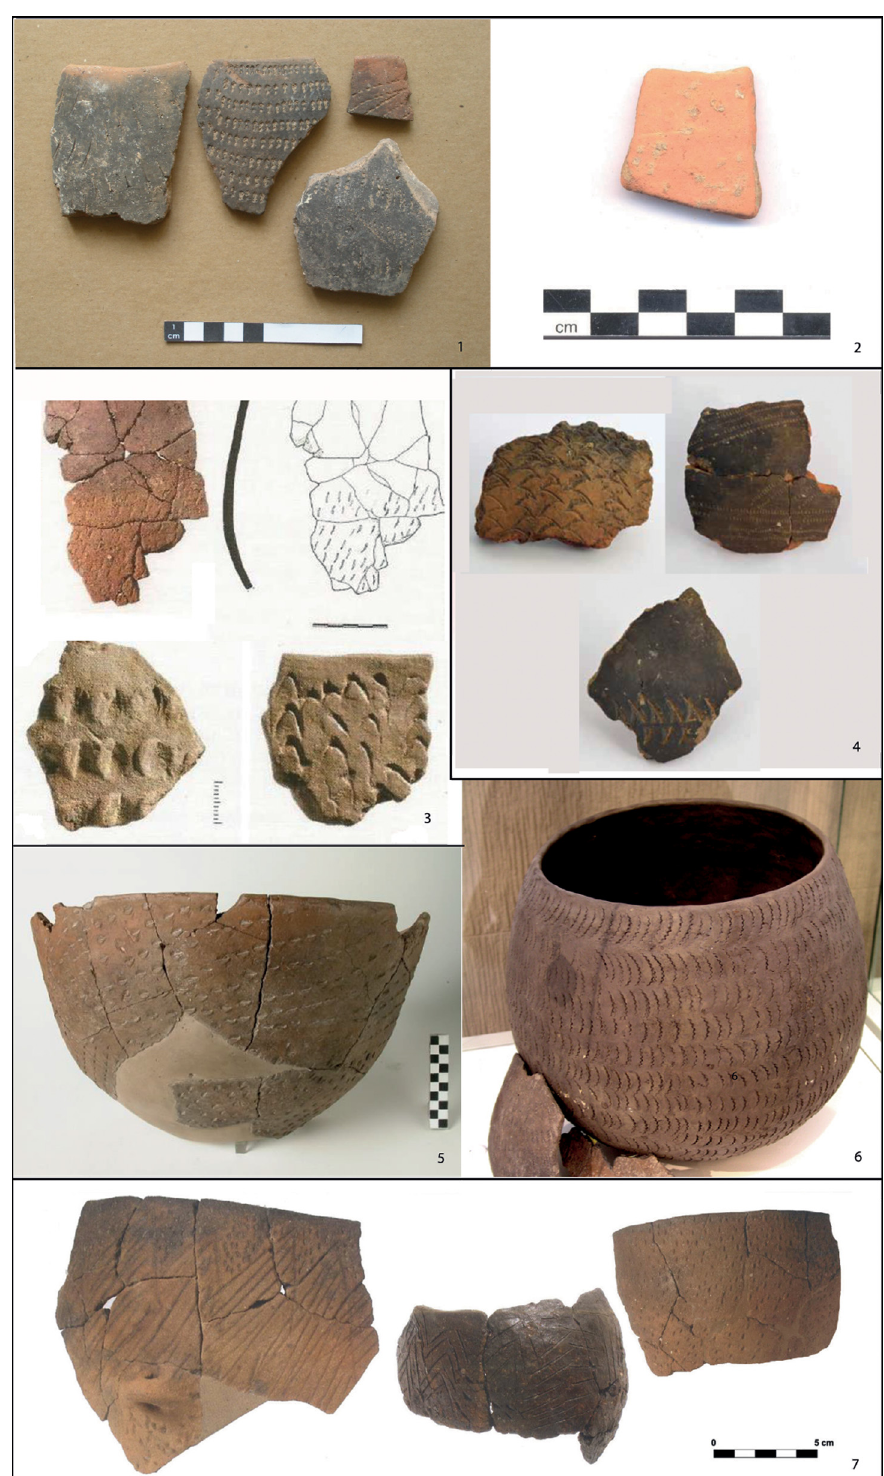
Figure 1: Impressed Ware pottery from the Adriatic - Ionian zone: ( 1 ) Pokrovnik ( Dalmatia ) ; ( 2 ) Ra š inovac ( Dalmatia ) : fi gulina ; ( 3 ) Sidari ( Corfu ) ; ( 4 ) Kargadur ( Istria ) ; ( 5 ) Favella ( Apulia ) ; ( 6 ) Crno Vrilo ( Dalmatia ) ; ( 7 ) Fornace Cappuccini ( Emilia - Romagna, Po Plain ) . Credits: 1, 2. E. Podrug, 3. Berger et al., 2014; 4. Kom š o and Č uka in Visentini & Podrug, 2014, no scale; 5. Tiné, 2009; 6. Marijanovi ć , 2009, no scale; and 7. Radi & Petrinelli,